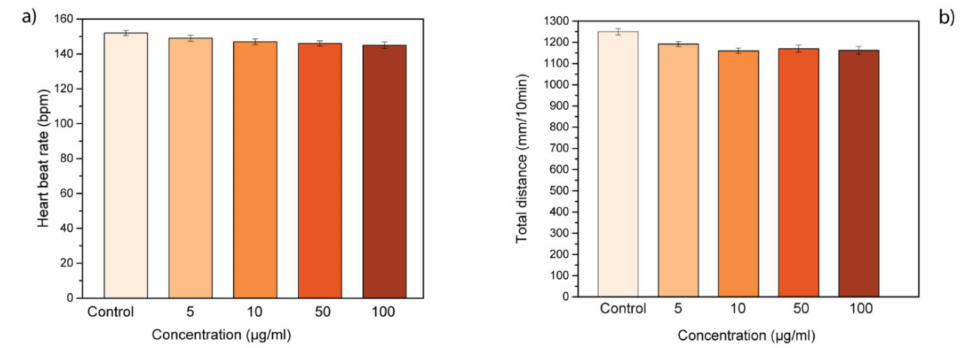
Figure 3. Behavioral e ff ects of GL layers on zebrafish development. ( a ) Heartbeat rate and ( b ) locomotor activity of zebrafish treated with GL layers.